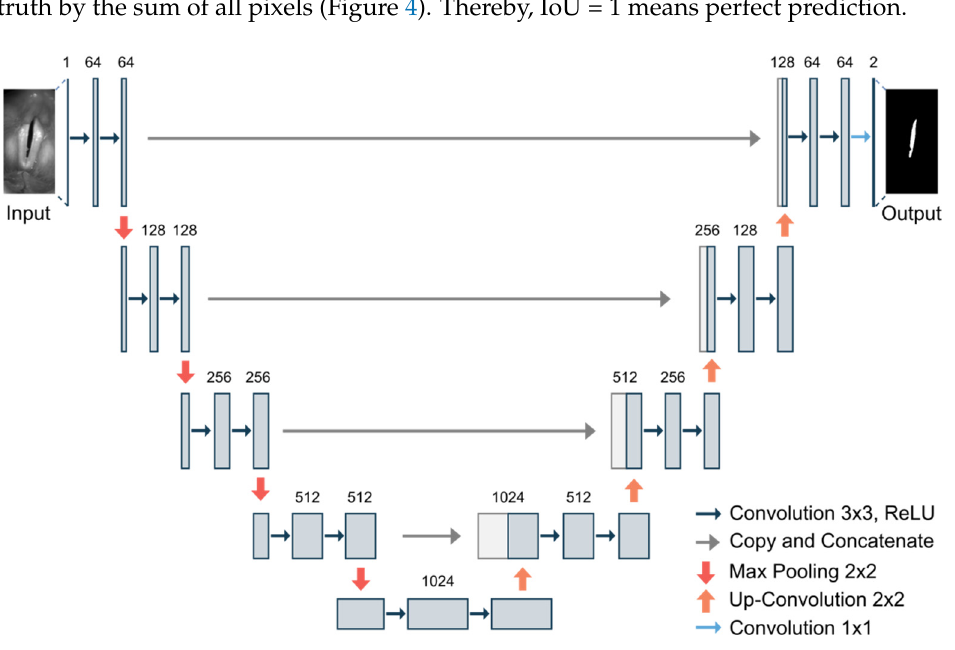
Figure 3. Illustration of the U-Net architecture based on ref. [22].